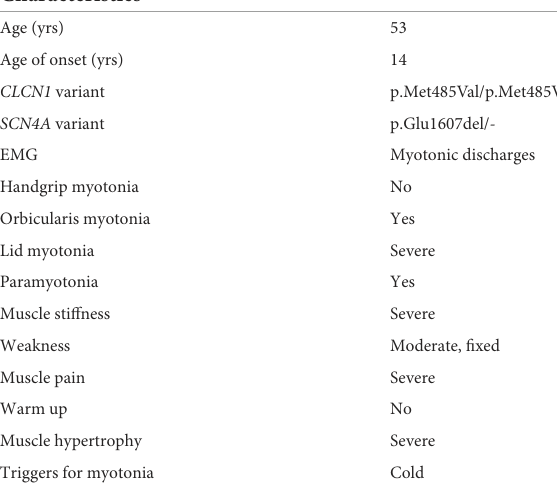
TABLE 1 Proband’s clinical features are recapitulated here.